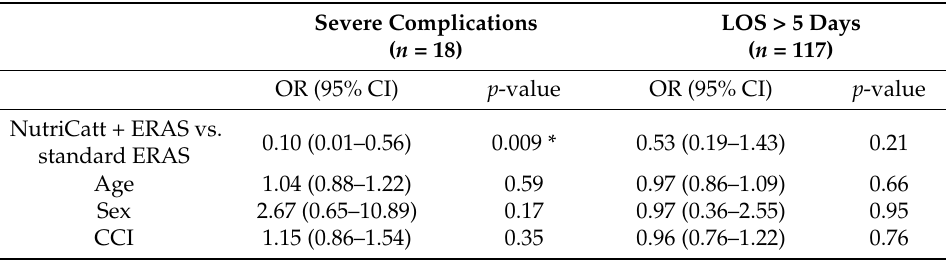
Table 4. Multiple Regression Analysis for Severe Postoperative Complications and LOS > 5